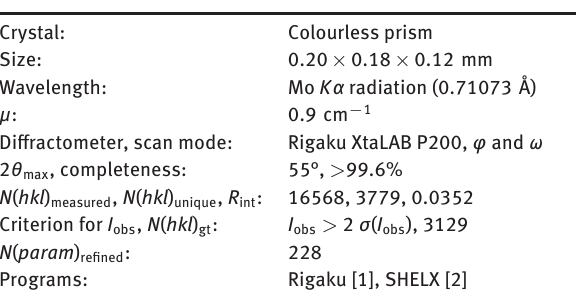
Table 1: Data collection and